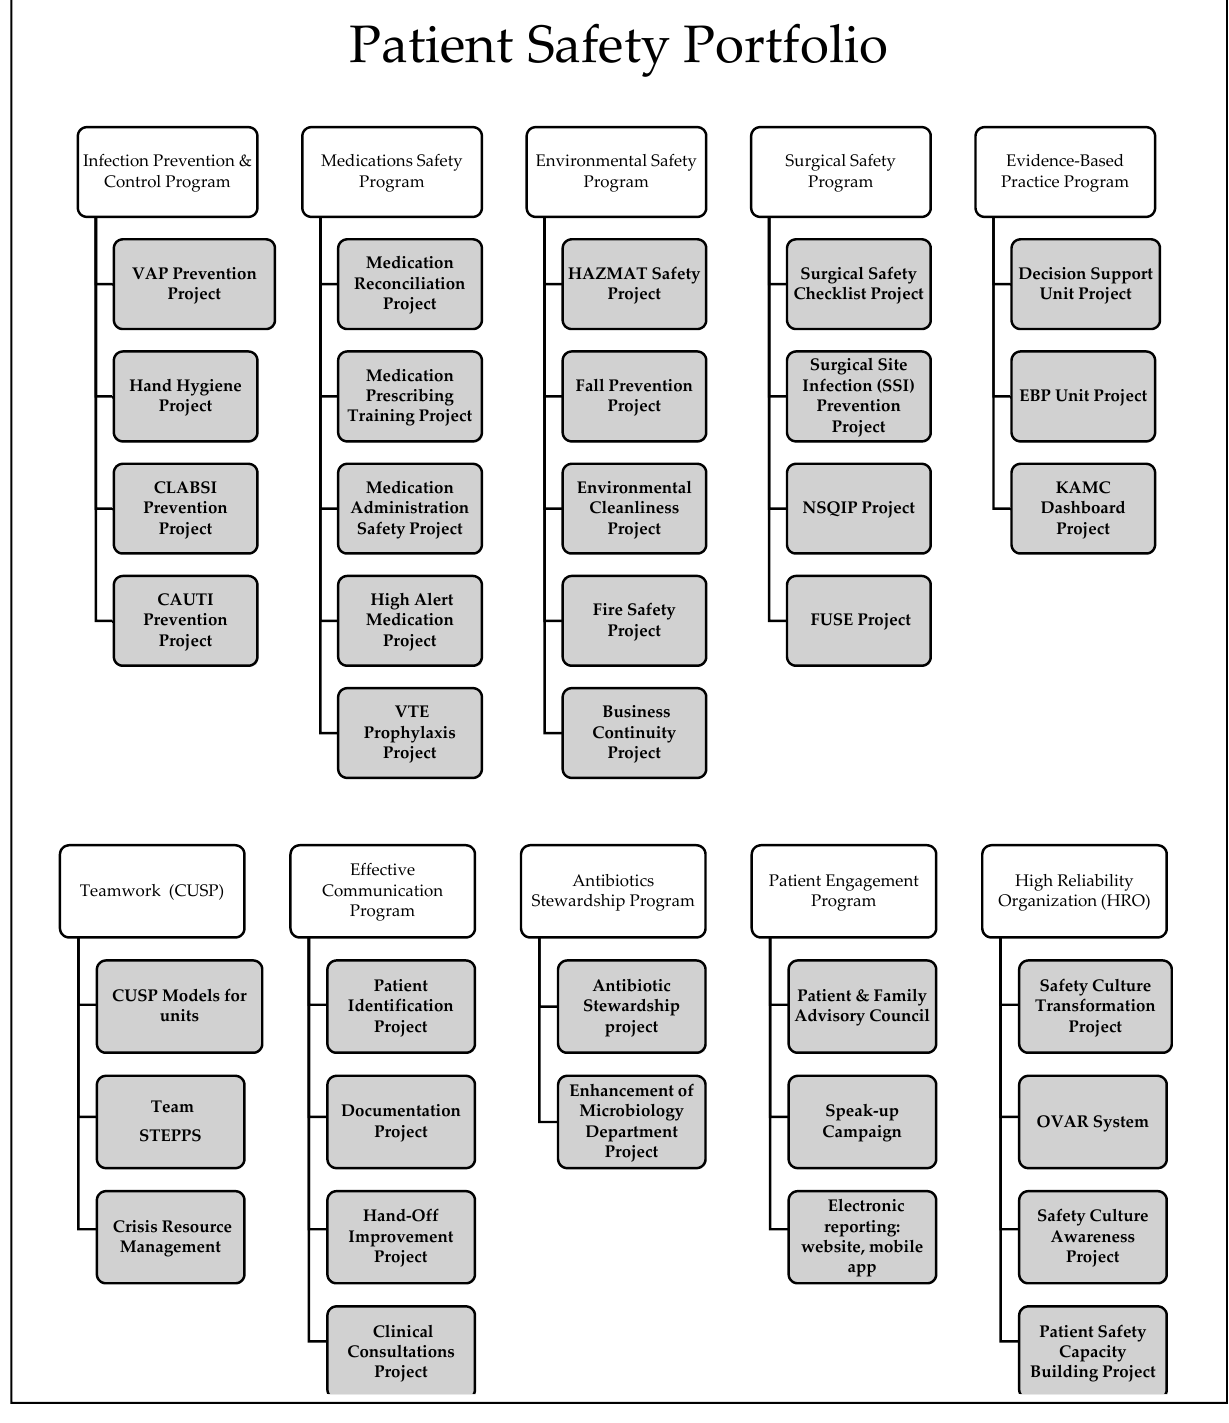
Figure 1. Patient safety portfolio of programs.